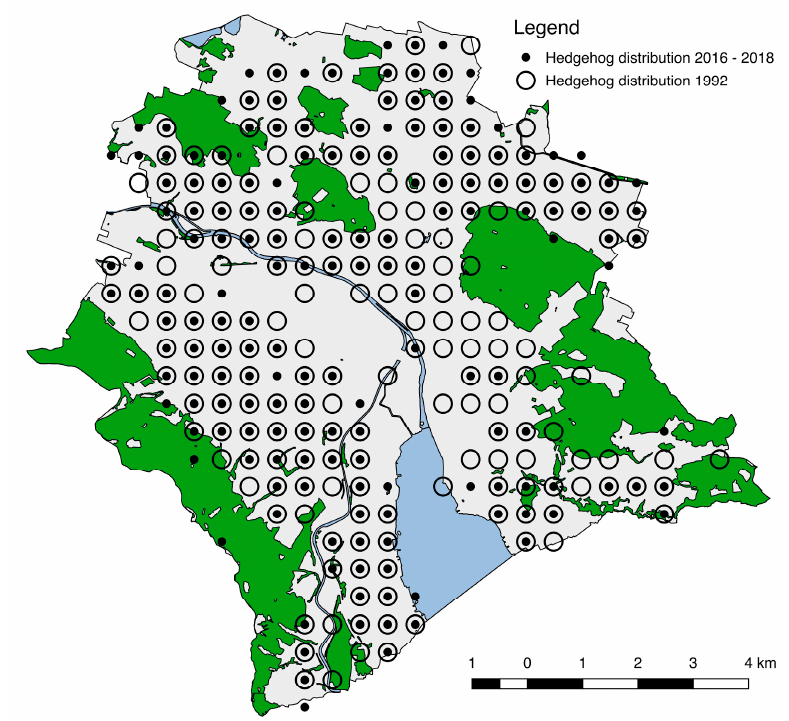
Figure 2. Distribution map of hedgehogs Erinaceus europaeus in the city of Zurich, Switzerland in the past study 25 years ago (1992, circles) and in the recent study (2016–2018, points). The outline delineates the municipal border of the city of Zurich with forest area (green) and water bodies (blue). Distribution circles represent the ¼ km 2 survey grid. The distribution of hedgehogs declined by − 17.6% (± 4.7%) in the 25 years between the studies.